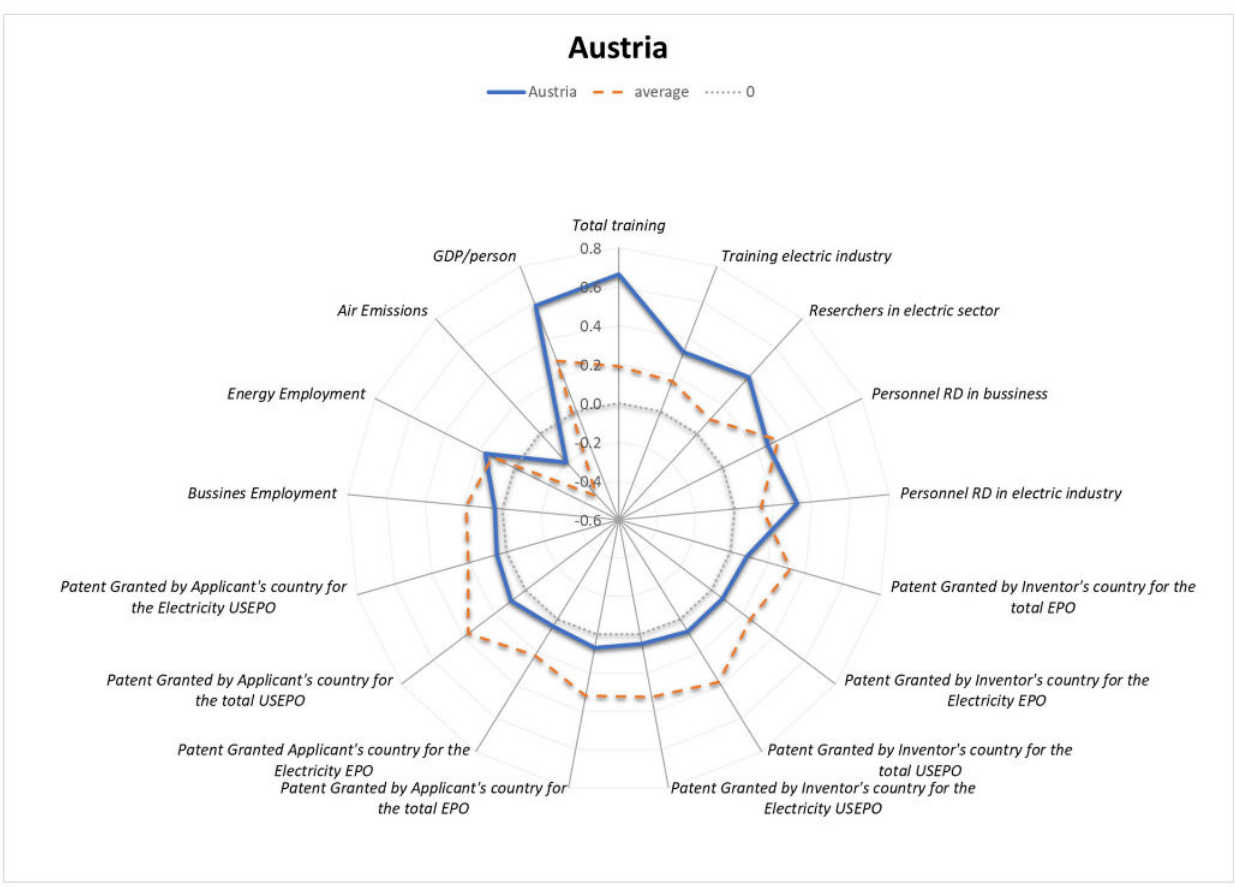
Figure 11. Synergy and trade-off occurrence—AT. Source: Authors’